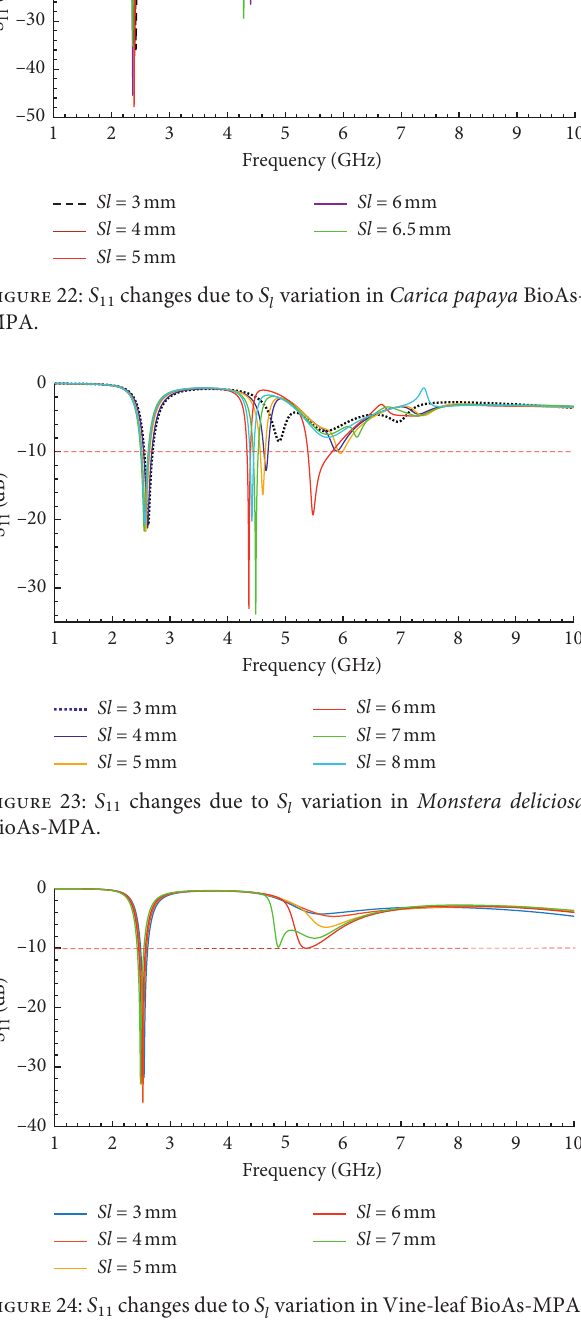
S l variation in Vine-leaf BioAs-MPA.